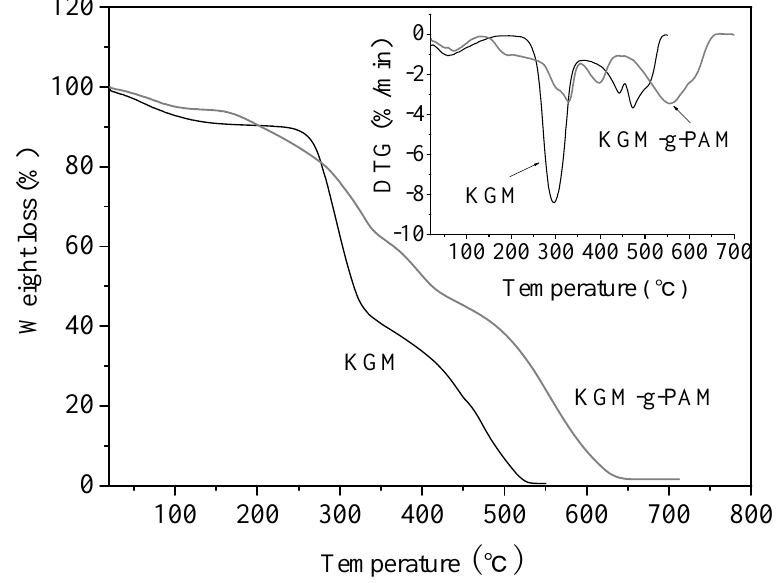
Figure 7 . TG and DTG curves of KGM and